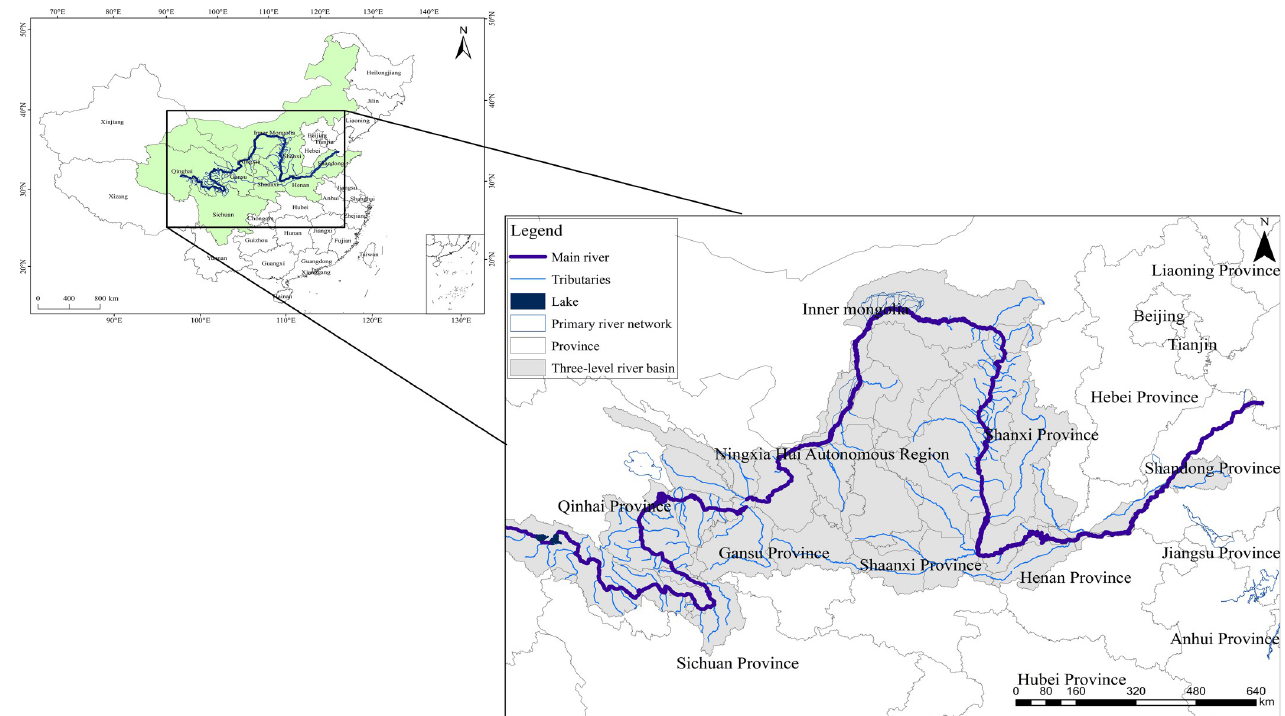
Fig 1. Overview of the study